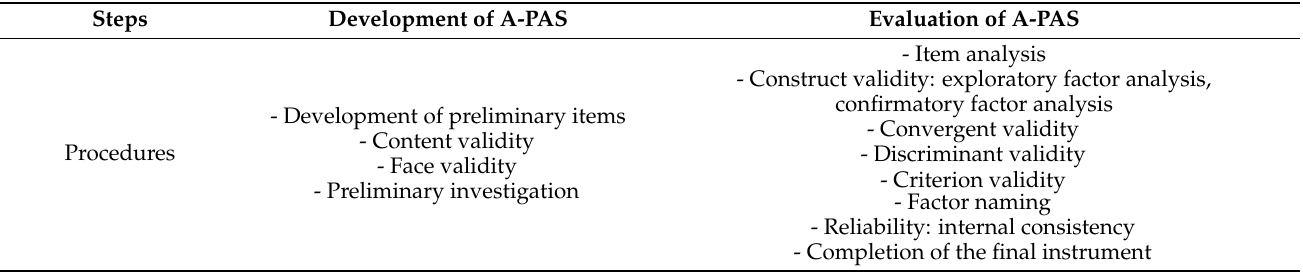
Table 1. Steps of development and evaluation of